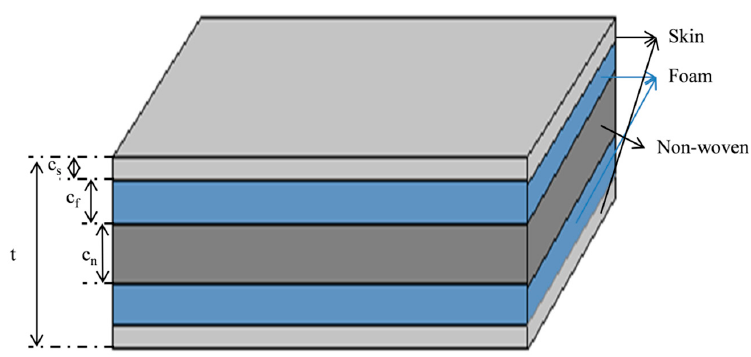
Figure 6. Schematic for calculation of the SW-3 and SW-4 samples.